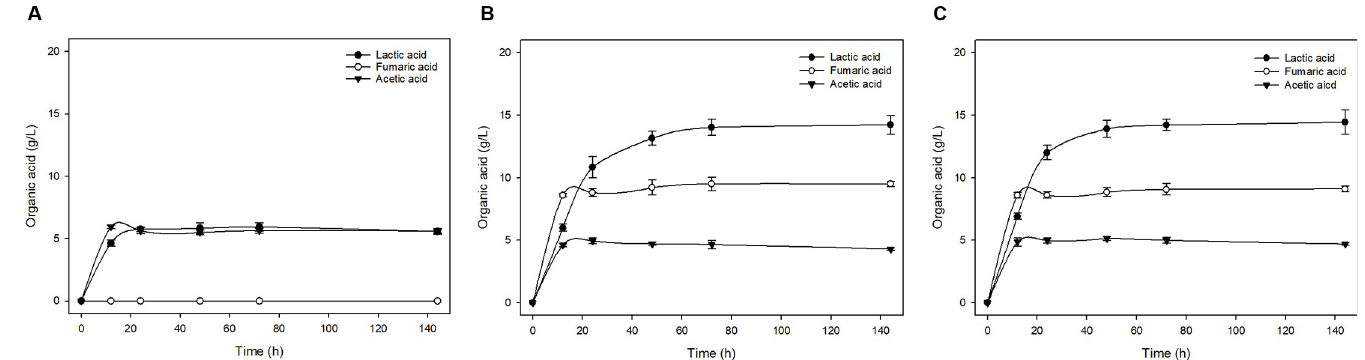
Fig 4. Separate hydrolysis and fermentation (SHF) processes. Time courses of organic acid production for the kimchi cabbage waste (KCW) of 3.0% (dry matter, w/ v). (A) W . cibaria WiKim28. (B) L . sakei WiKim31. (C) L . curvatus WiKim38.